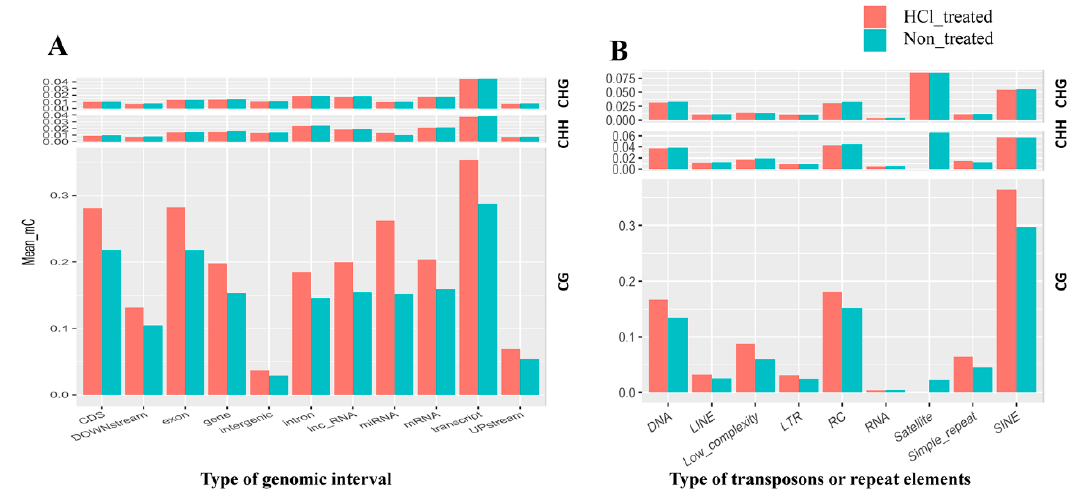
Figure 5. DNA methylation patterns in different genomic regions. Methylation percentages of different genetic elements, including CDS, downstream, exon, gene, intergenic, intron, inc-RNA, miRNA, mRNA, transcript, and upstream ( A ). Methylation percentages of transposon elements (TEs) and repeat elements (REs) ( B ). DNA, long interspersed nuclear elements (LINE), short interspersed nuclear elements (SINE), retrotransposons (RC) and long terminal repeats (LTR) are classified as TE, and Simple_repeat, Low_complexity, satellite and RNA are classified as RE.